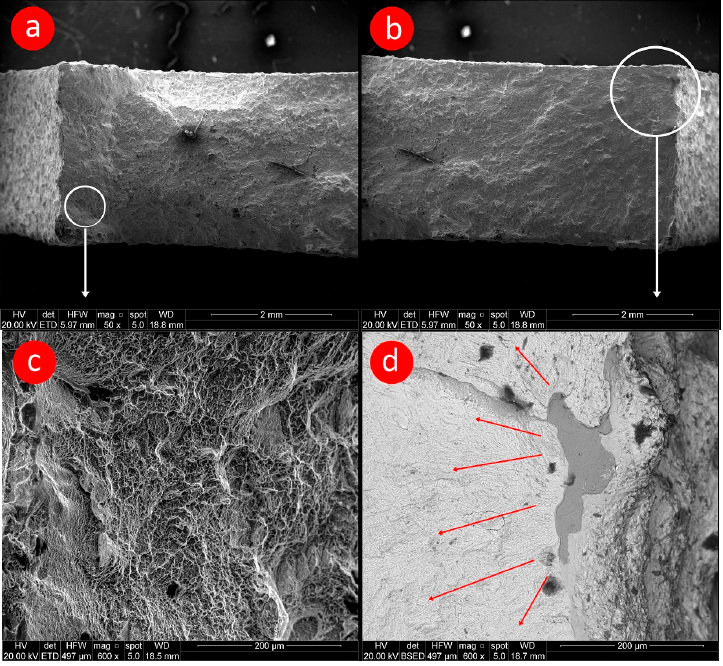
Figure 6. ( a – d ) ESEM fractographs of the smooth specimen ( Δσ = 360 MPa, Cycles Number = 106374).